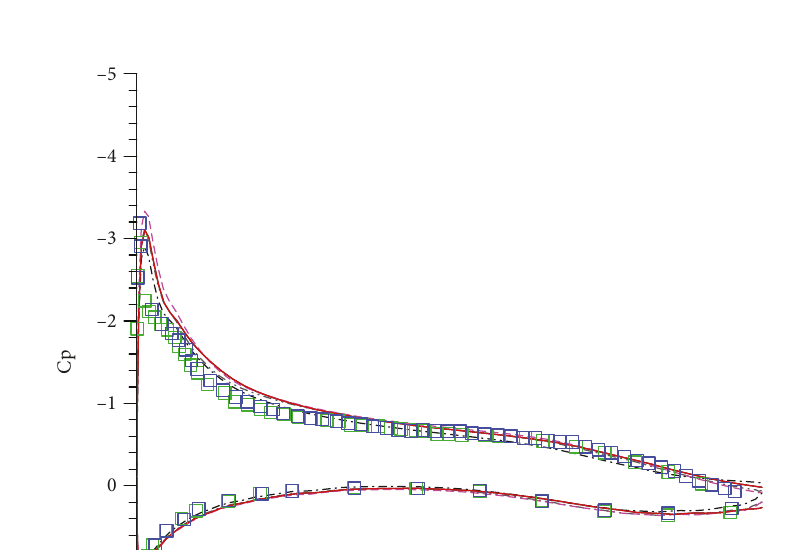
Figure 5: 2D planar BGK wing.